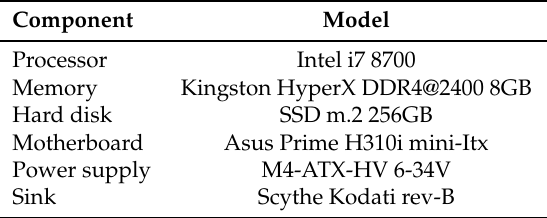
Table 3. Computer components.